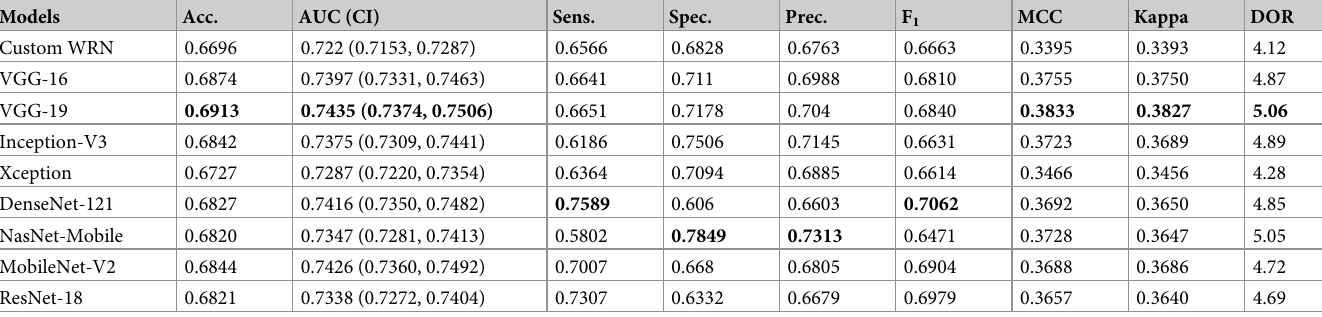
Table 3. Performance metrics achieved during the first-stage of CXR-specific pretraining. Models